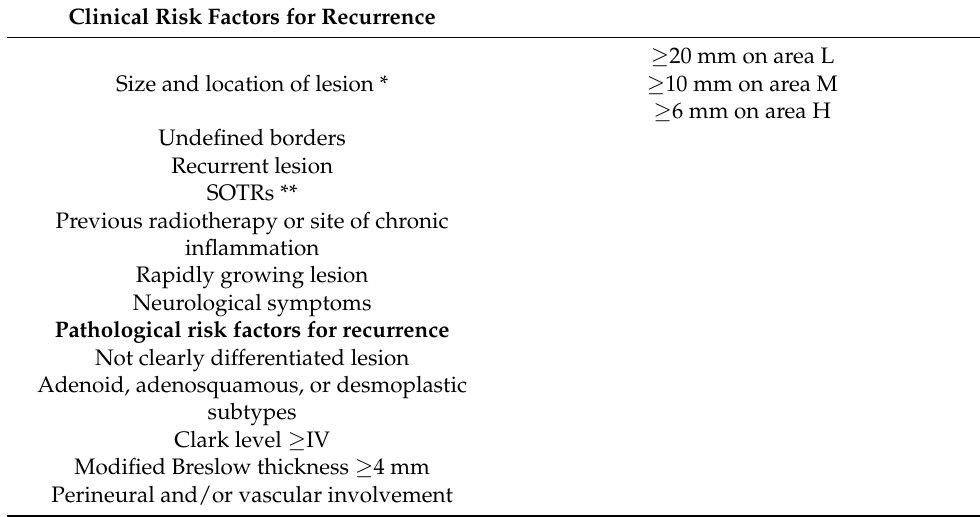
Table 1. Clinical and pathological risk factors for recurrence